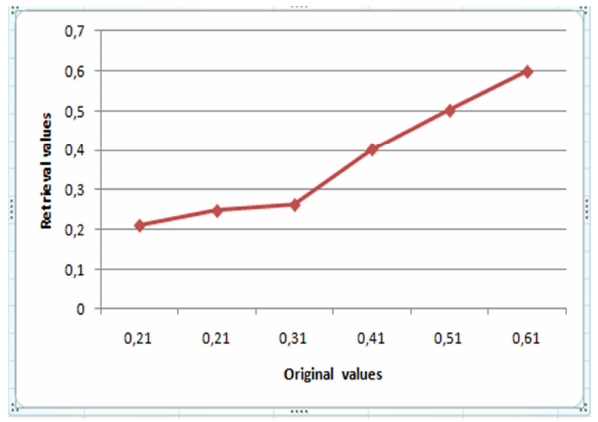
Figure 16. The retrieving roughness parameter gggg 1 after the inversion by the NN function of its original value